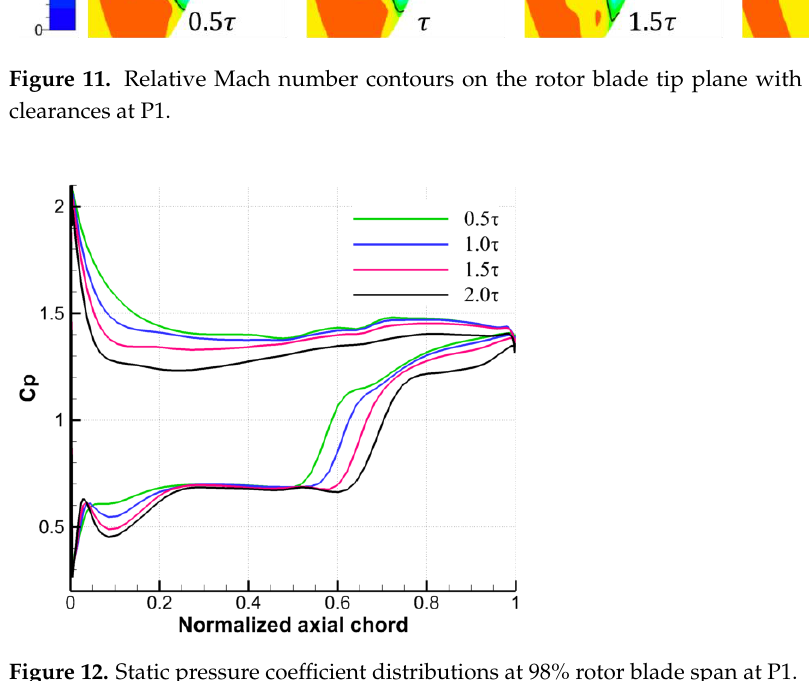
Figure 12. Static pressure coefficient distributions at 98% rotor blade span at P1.